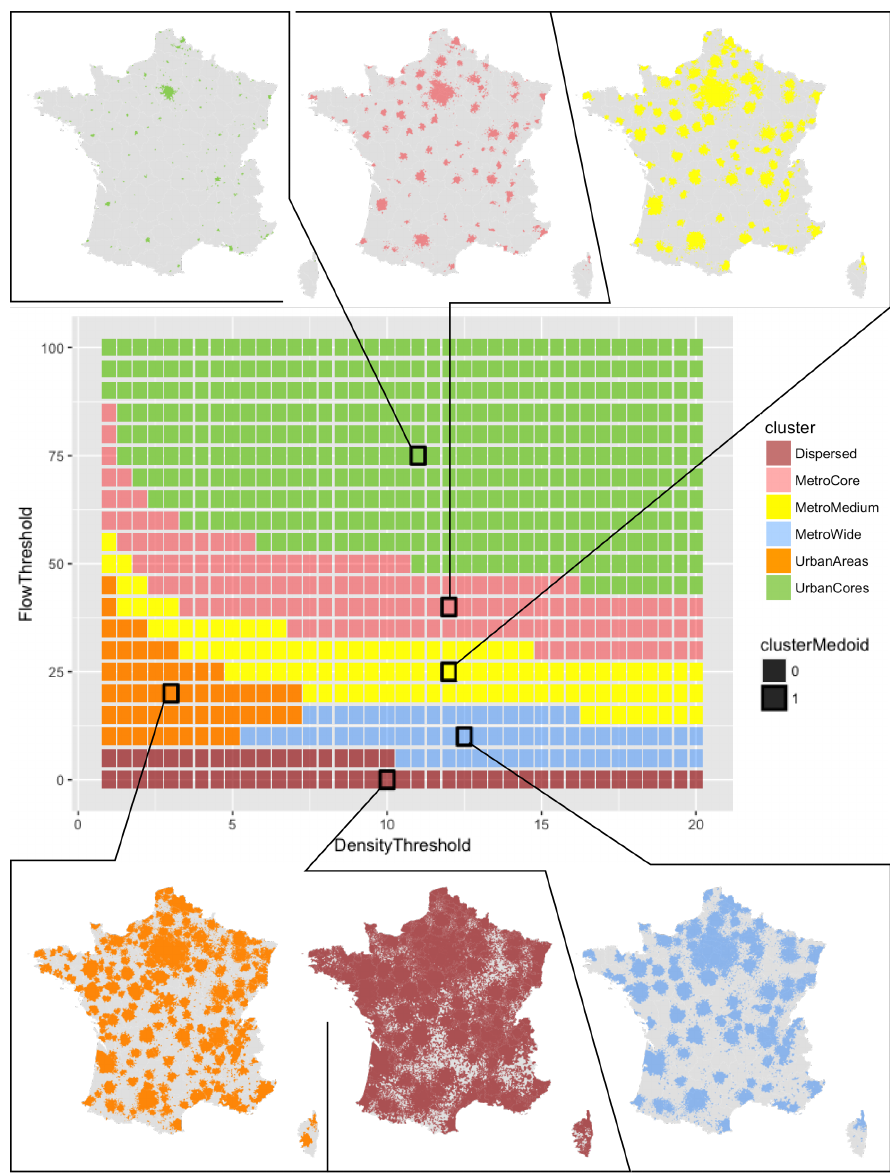
Figure 3. Results of clustering: 6 classes of city definitions (Population >